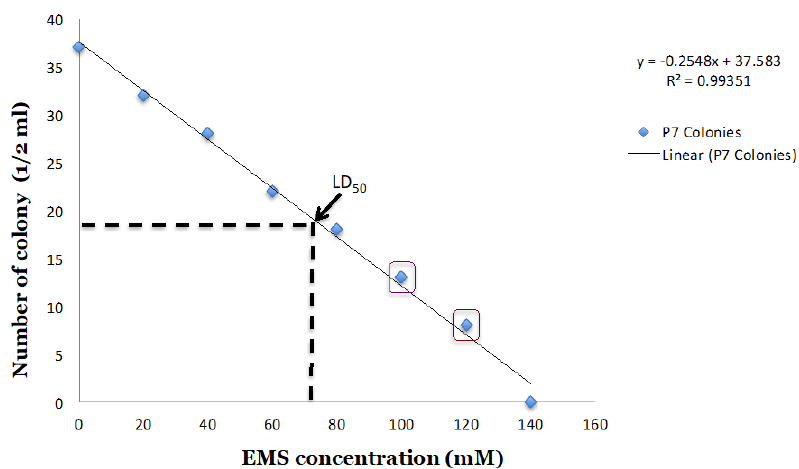
Figure 3. Correlation between the number of colonies and ethyl methanesulfonate (EMS) concentrations. Eight ethyl methanesulfonate (EMS) concentrations have been used to mutagenize the Clostridium carboxidivorans P7 wild type culture. Concentrations above 140mM were lethal for the P7 strain. Mutational rates show an LD 50 of 74.89mM of EMS treatment. 40 (purple box) and 15 (brown box) EMS mutants were randomly isolated from 100 mM and 120mM EMS treatment, respectively.